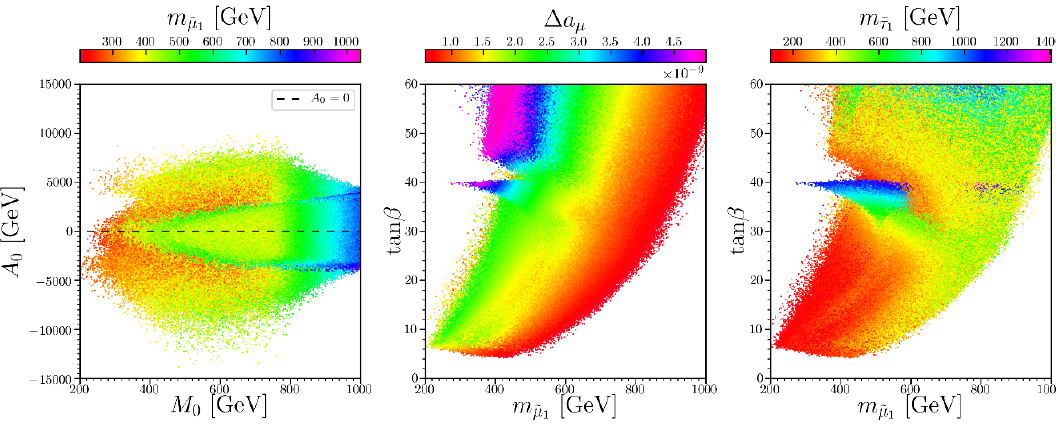
Figure 3 . Surviving samples in the A 0 versus M 0 (left), and tan (cid:12) versus the lighter smuon mass m ~ (cid:22) (middle and right) planes, with colors indicating m ~ (cid:22) 1 (cid:1) a (cid:22) (middle), and the lighter stau mass m ~ (cid:28) larger-(cid:1) a (cid:22) samples are projected on top of smaller